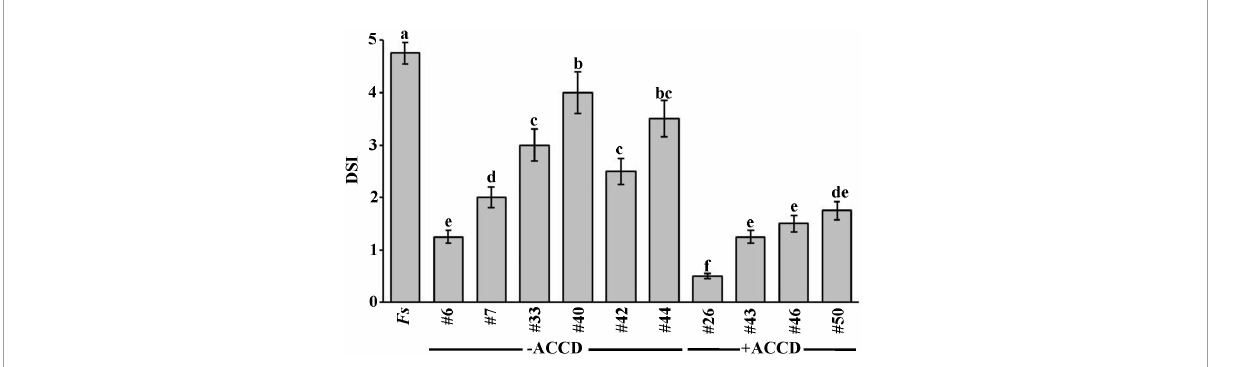
FIGURE1 In vivo effect of selected BCAs on date palm seedlings inoculated with Fusarium solani (Experiment 1). Disease severity index after the recovery of affected date palm seedlings from the fungal pathogen, F. solani , at 35 dpt with the BCA under greenhouse conditions. DSI was based on a scale of 5:0 = no infection, 1 = 1–10, 2 = 11–25, 3 = 26–50, 4 = 51–75, and 5 = 76–100% damage including necrosis, white area in leaves or rotting in roots. Values with different letters are significantly different from each other at P < 0.05. Bars represent standard errors.